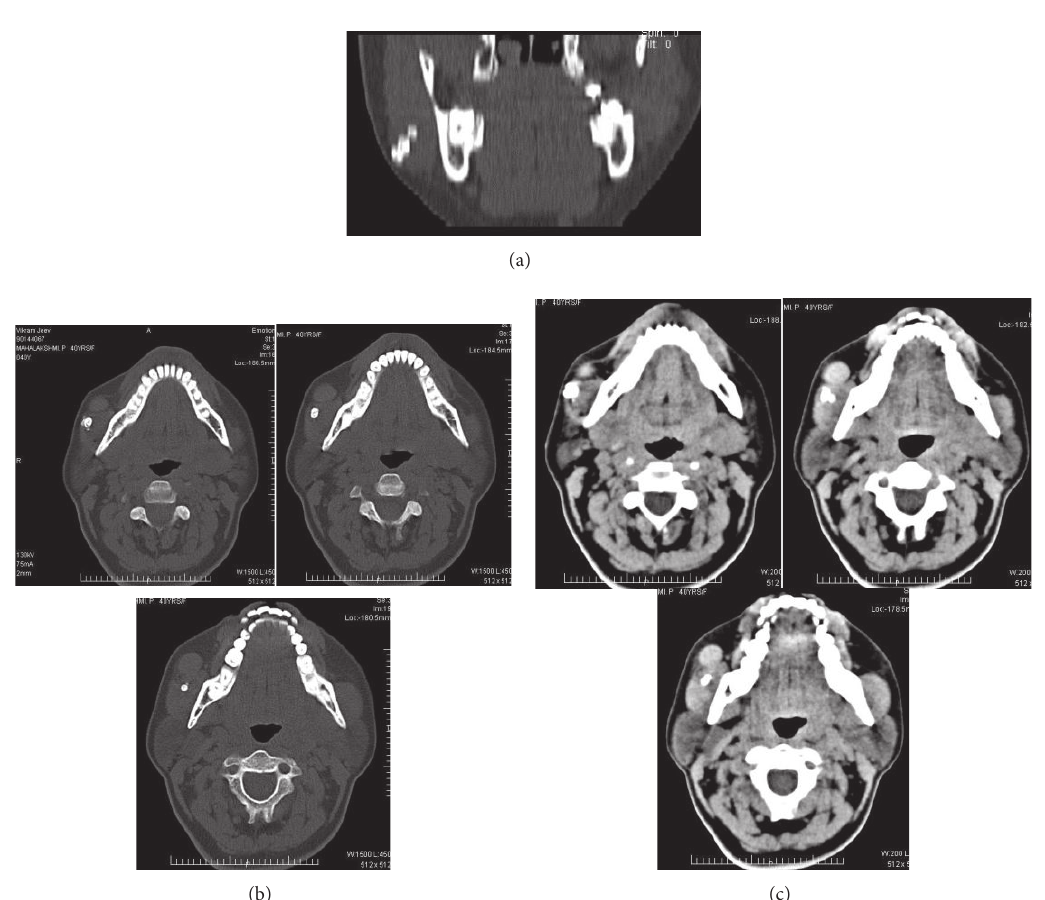
Figure 7: (a) Positions of the calcific structures noted in coronal CT section. (b) Bone window axial CT image shows position of the calcific structures at various depths. (c) Soft tissue window axial CT image clearly showing the boundaries of the mass.